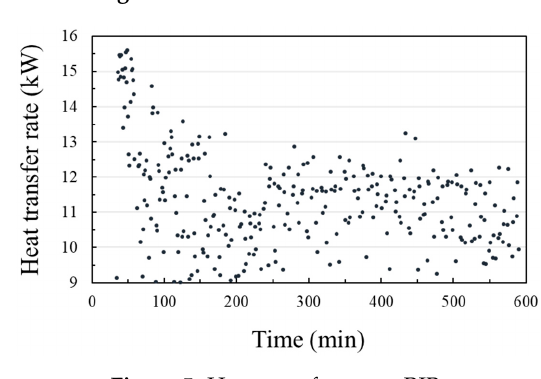
Figure 5. Heat transfer rate—RIB.